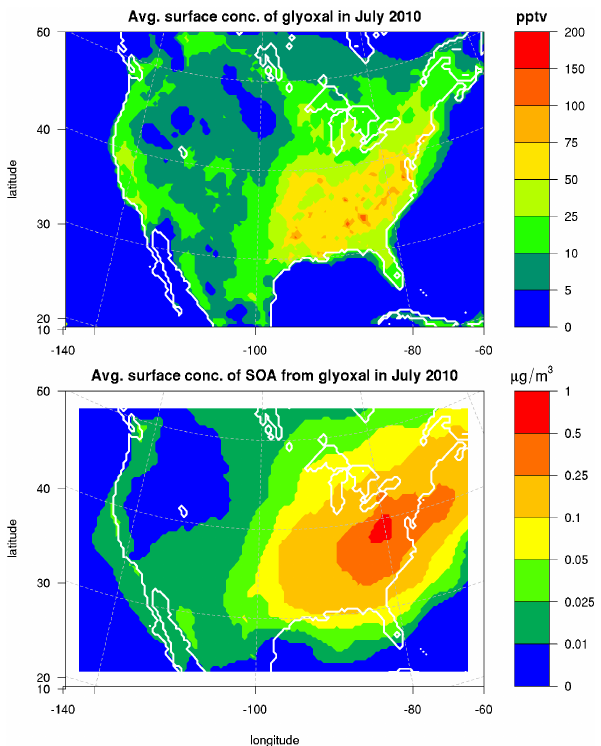
Figure 15. Average surface level concentration of gas-phase gly- oxal (top) and SOA from glyoxal (bottom) in July 2010 over the continental United States. Simulation based on the VOLUME pa-